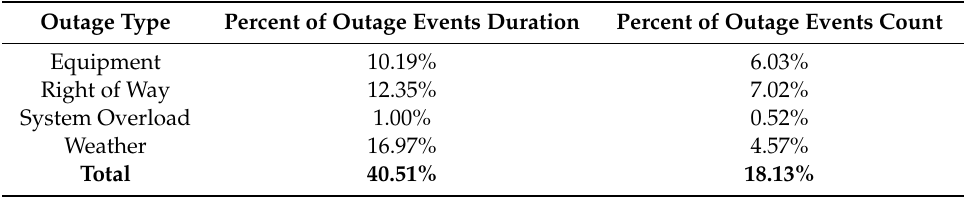
Table 2. Power-outage cause